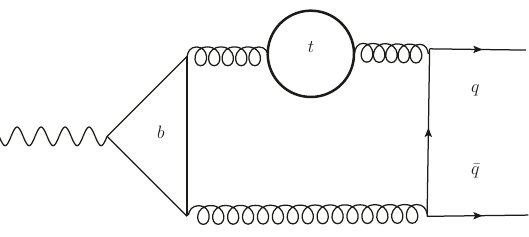
Figure 7 . A representative diagram contributing to F A